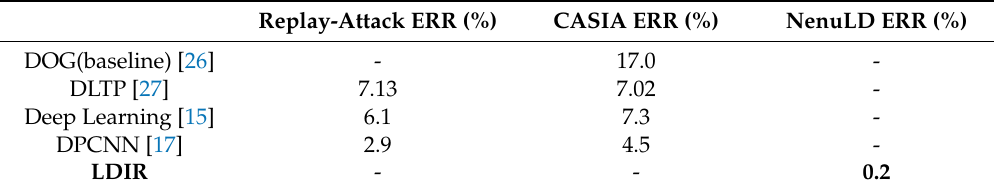
Table 2. Comparison of liveness detection with cross-databases.